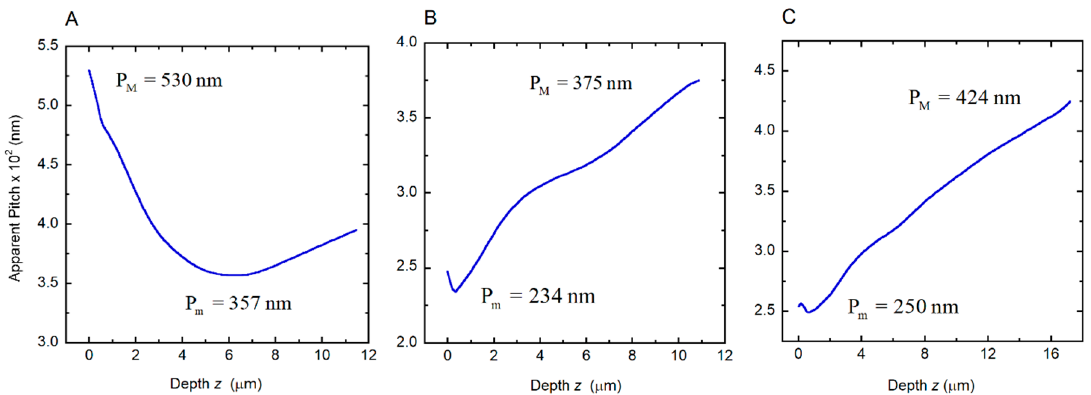
Figure 4. Depth dependences of the apparent pitches of the cuticles of ( A ) golden C. chrysargyrea , ( B ) silvery C. chrysargyrea , and ( C ) silvery C. optima scarab beetles. Maximum ( P M ) and minimum ( P m ) values of the apparent pitches are indicated.